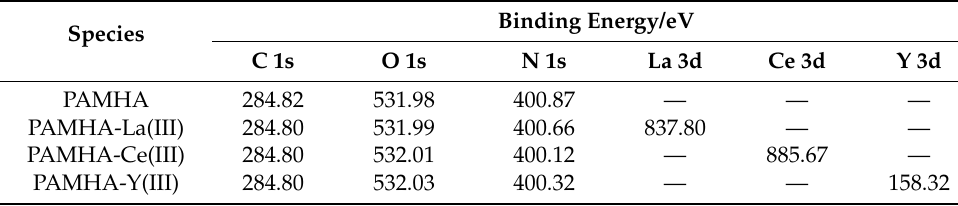
Figure 4. X-ray photoelectron spectroscopy (XPS) spectra of PAMHA before and after adsorption. ( a ) Full spectrum; ( b – d ) high-resolution XPS spectra of C 1s, N 1s, and O 1s. Table 4. Electronic binding energy of PAMHA before and after